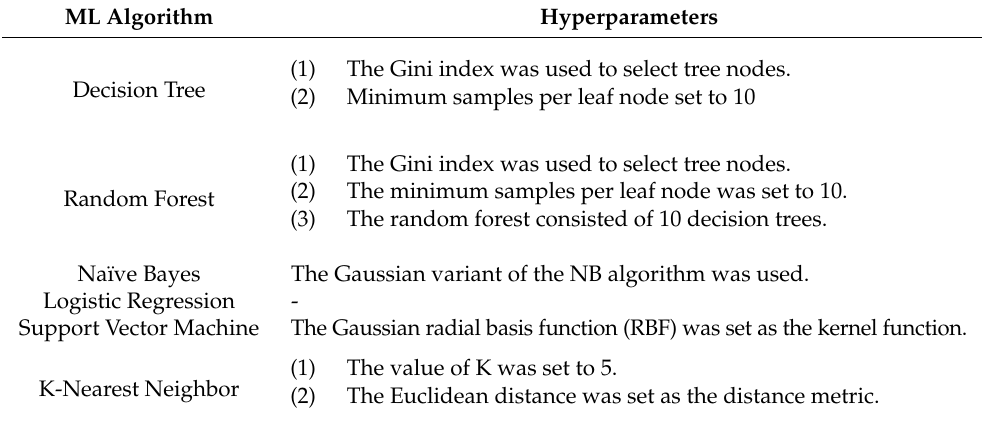
Table 9. Summary of the hyperparameters of each ML algorithm when the ML algorithm requires a hyperparameter to be set.